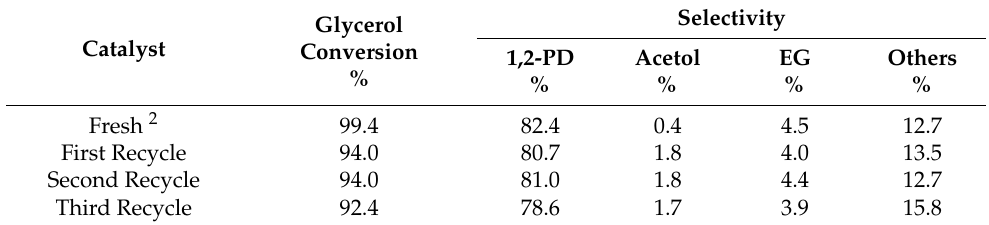
Table 4. Activities of the recycled catalysts 1 .